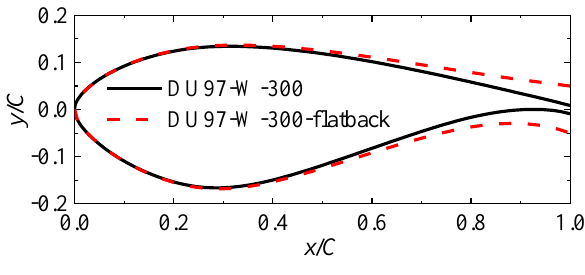
Figure 3. Airfoil geometry.